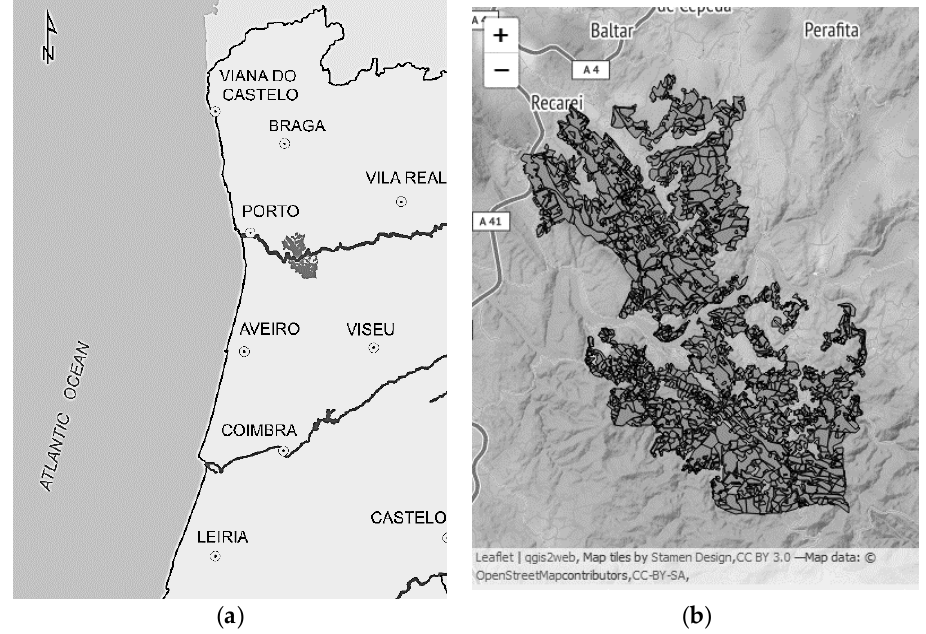
Figure 1. Zona de Intervenção Florestal (ZIF) Paiva and Entre-Douro e Sousa. ( a ) location of the study area in Portugal; ( b ) classification of the study area into stands.